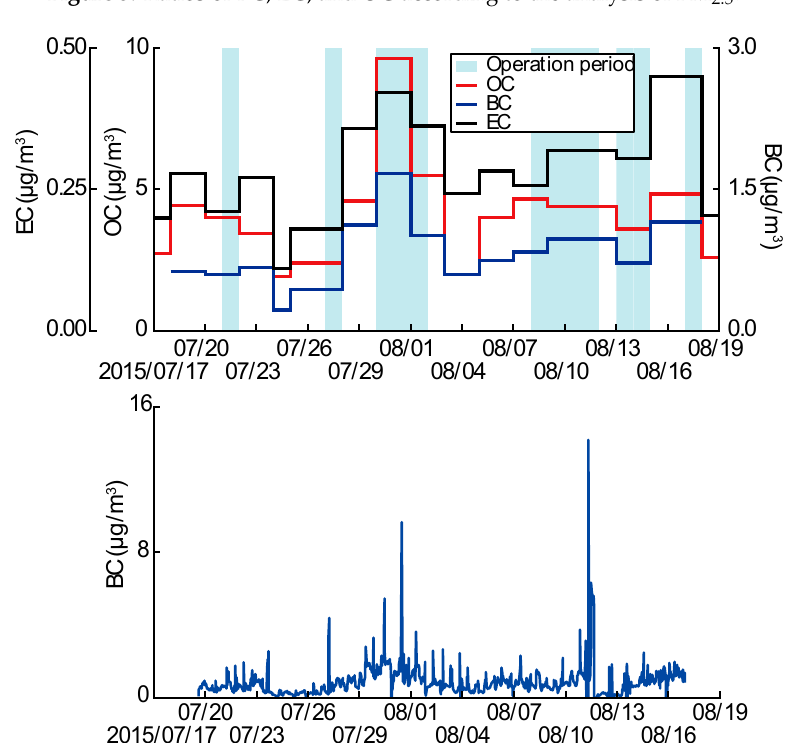
Figure 6. Time series concentrations of OC, EC, and BC and the operational period of the asphalt mix plant.